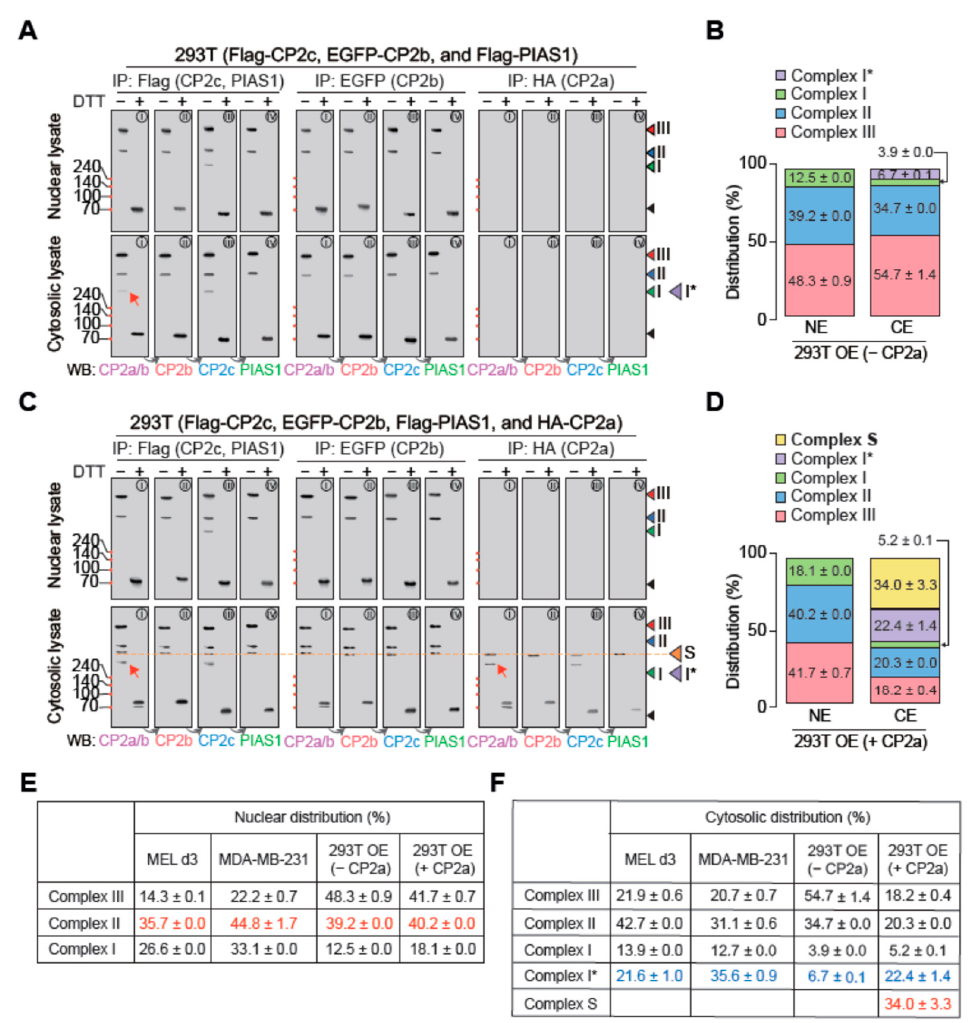
Figure 6. Subcellular distribution and dynamics of various CP2c complexes in cells with overexpression of CP2c complex proteins. ( A , B ) CP2c complex types and subcellular distribution of each complex in 293T cells where epitope tagged CP2c complex proteins (Flag-CP2c, EGFP-CP2b, and Flag-PIAS1) were ectopically overexpressed. ( C , D ) CP2c complex types and subcellular distribution of each complex in 293T cells where epitope tagged CP2c complex proteins (Flag-CP2c, EGFP-CP2b, and Flag-PIAS1) and CP2a were ectopically overexpressed. Immunoblots ( A , C ) showing various CP2c complexes in the nucleus (top) and cytosol (bottom) and the quantified distribution plots of each complex in the nucleus and cytosol ( B , D ). Red arrows in the immunoblots highlight the existence of CP2a in the cytosol-specific CP2c complex, complex I* ([C2A2]). The red dotted line indicates another cytosolic CP2c complex, complex S that appeared in cells by ectopic overexpression of CP2c complex proteins. Samples were subjected to 10% SDS-PAGE. ( E , F ) Estimated ratios of each CP2c complex in the nucleus ( C ) and cytosol ( D ) in comparison with those of d3 MEL and MDA-MB-231 cells.